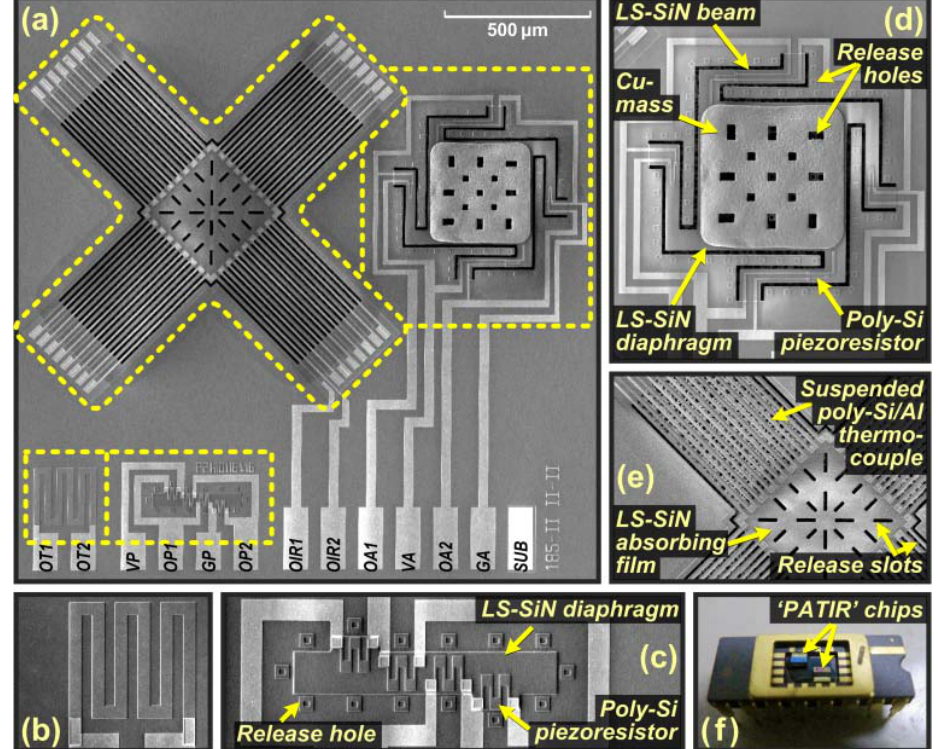
Figure 4. Photos showing the prototype PATIR composite sensor: ( a ) and ( f ) full views, ( b ) thermistor, ( c ) piezoresistive absolute-pressure sensor, ( d ) piezoresistive accelerometer, ( e ) thermoelectric infrared